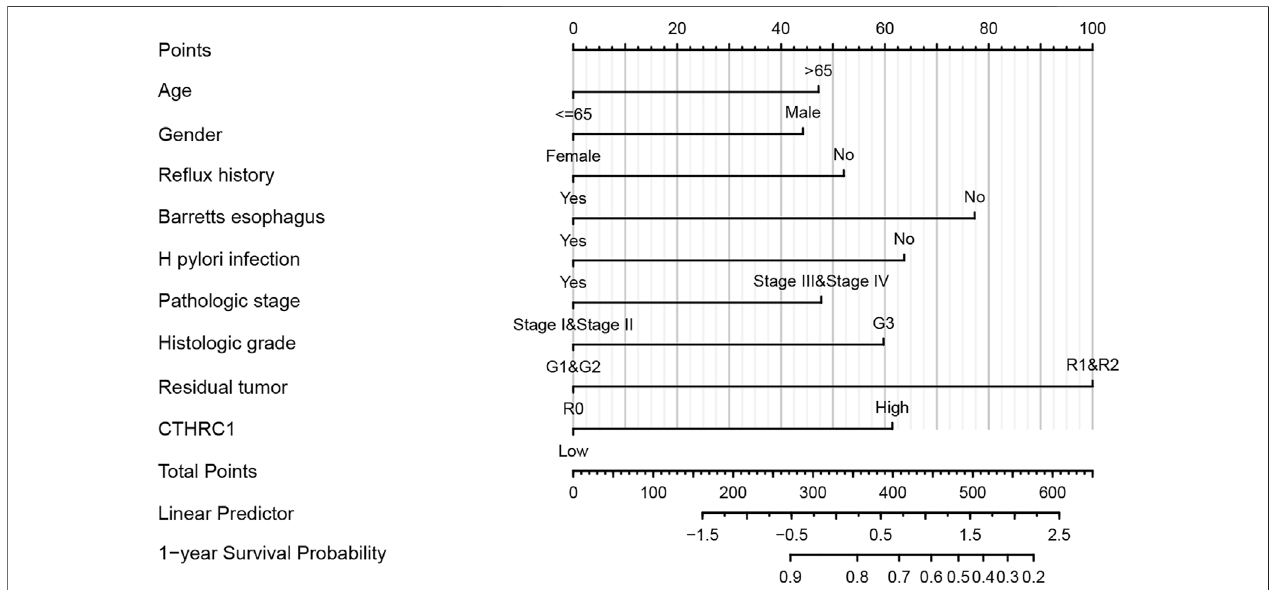
FIGURE 7 | Developed overexpressed CTHRC1 nomogram. Note: The nomogram was developed in the cohort, with age, gender, re fl ux history, Barret ’ s esophagus, Helicobacter pylori ( H. Pylori ) infection, pathologic stage, histologic grade, resident tumor. (C-index: 0.709, 95% CI, 0.678 – 0.740).